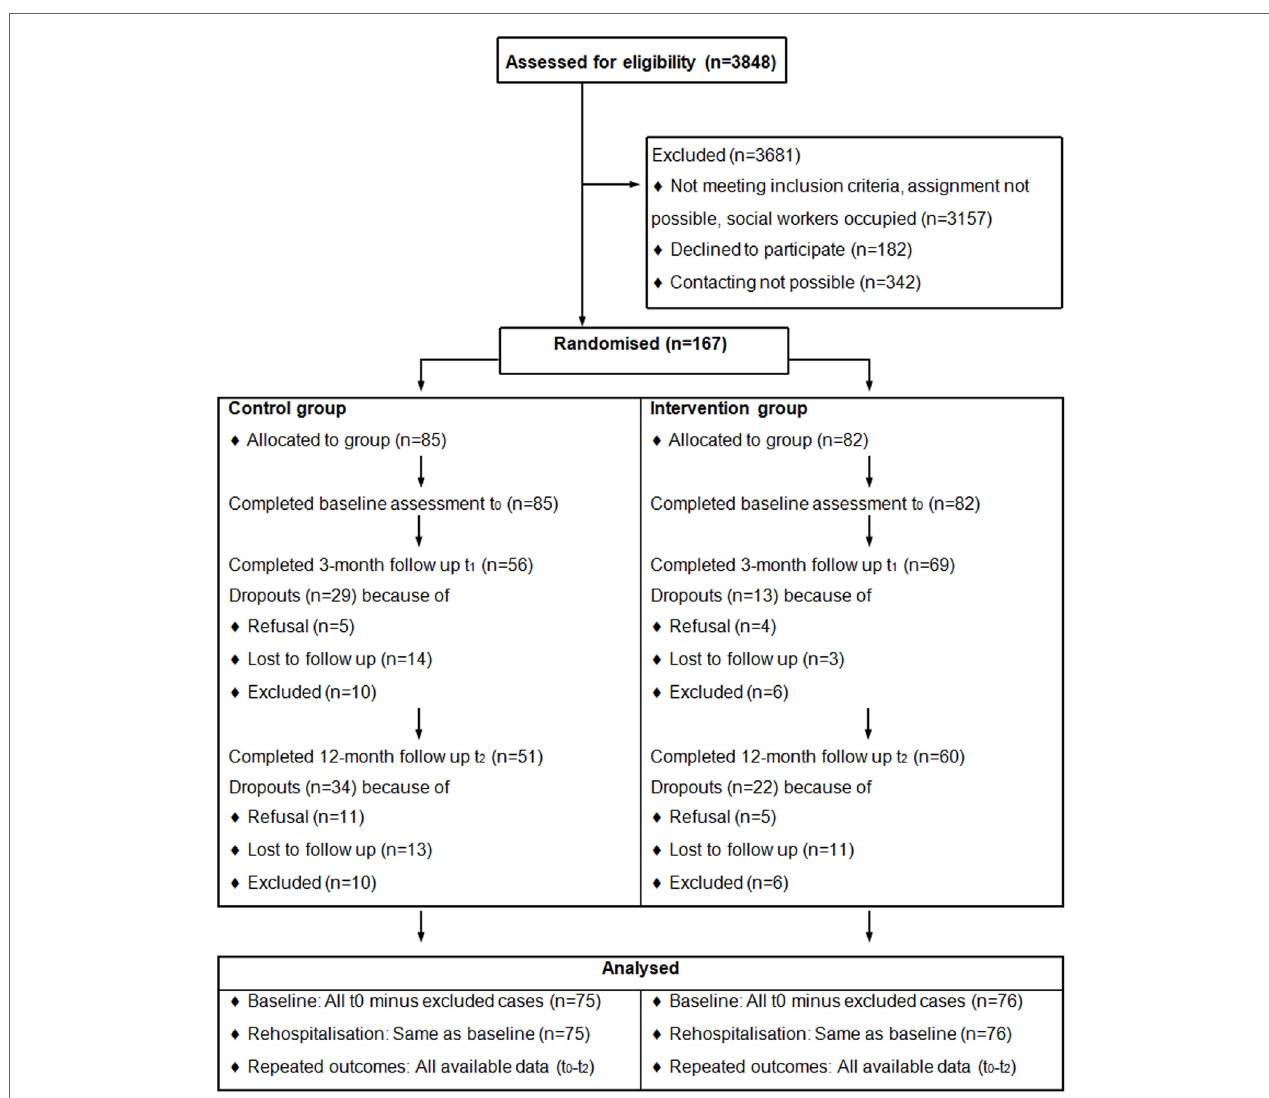
FiGUrE 1 | Participants flow-chart